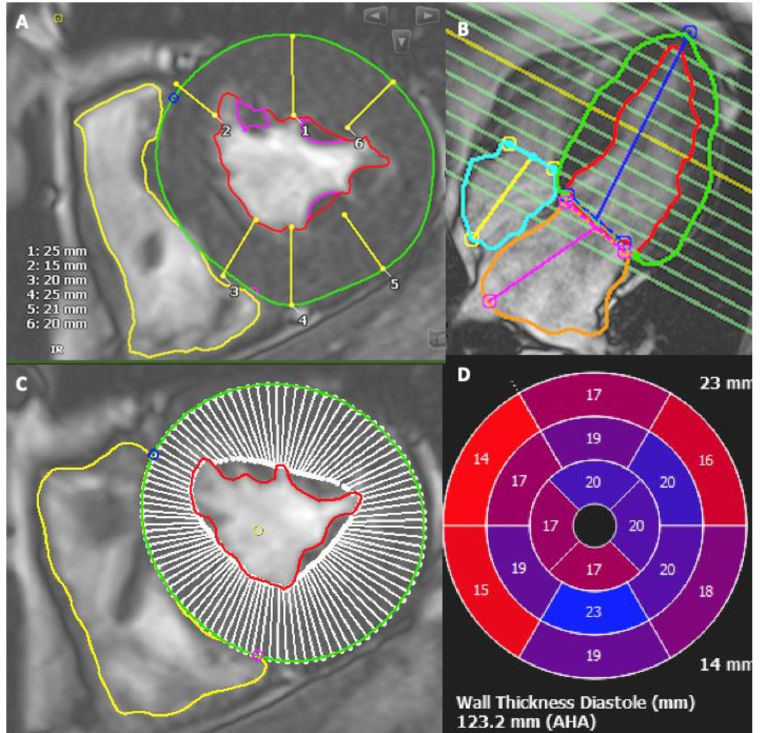
Figure 3. CMR analysis of wall thickness using manual contouring versus AI. ( A ): Manual contouring and corresponding quantification of MWT using a 3D short-axis stack image of the mid-wall of the LV. ( B ): Corresponding 4-chamber view demonstrating the mid-wall slice through the LV where the manual/AI contouring is completed. ( C ): Semi-automated AI-generated quantification of wall thickness derived from 3D short axis imaging demonstrating end-diastolic MWT. ( D ): Corresponding map of AI-generated MWT measurements (millimetres) from base-apex of the LV. Images contoured and semi-automated AI conducted using cvi42 version 5.11.2 (Circle Cardiovascular Imaging, Calgary, AB,